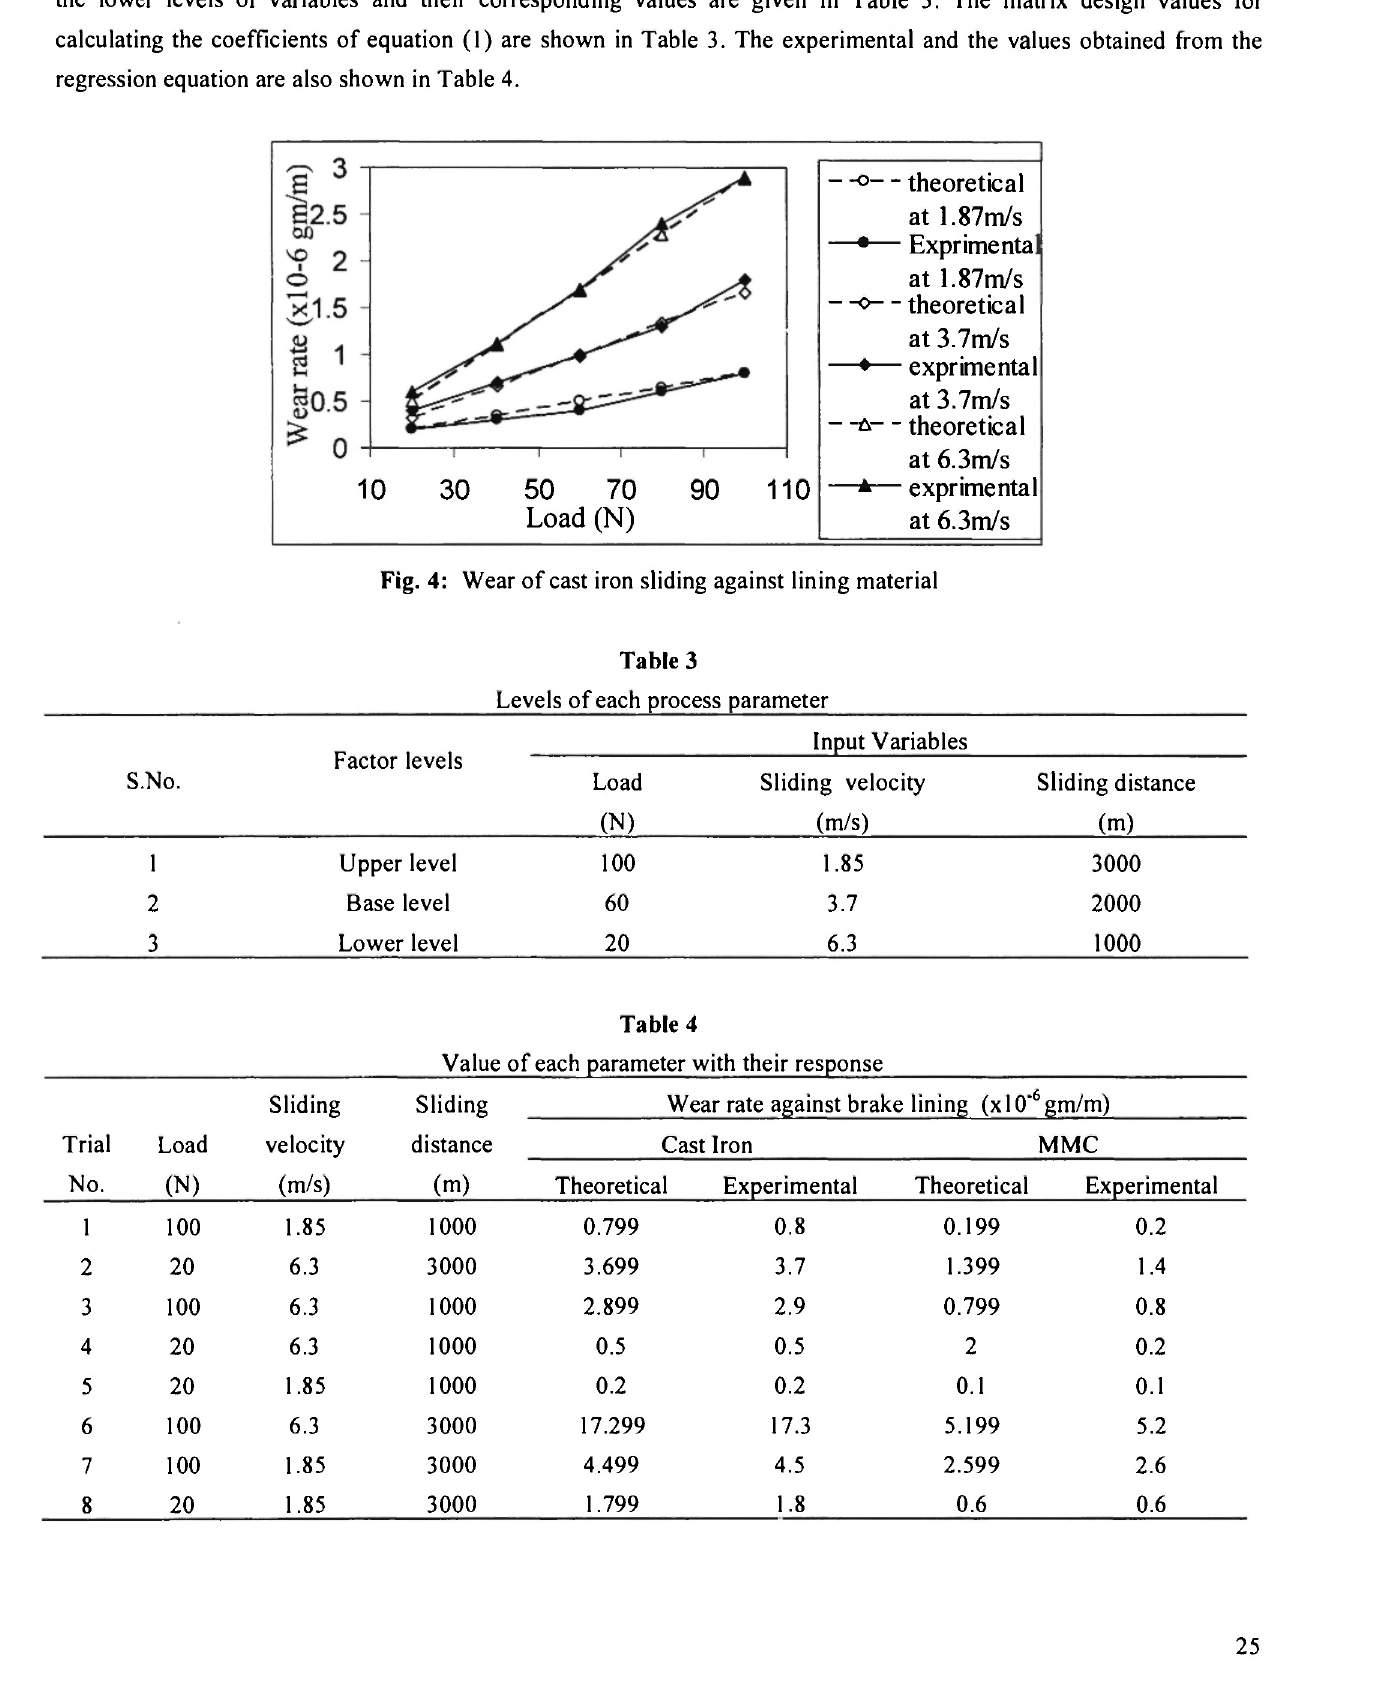
Levels of each process